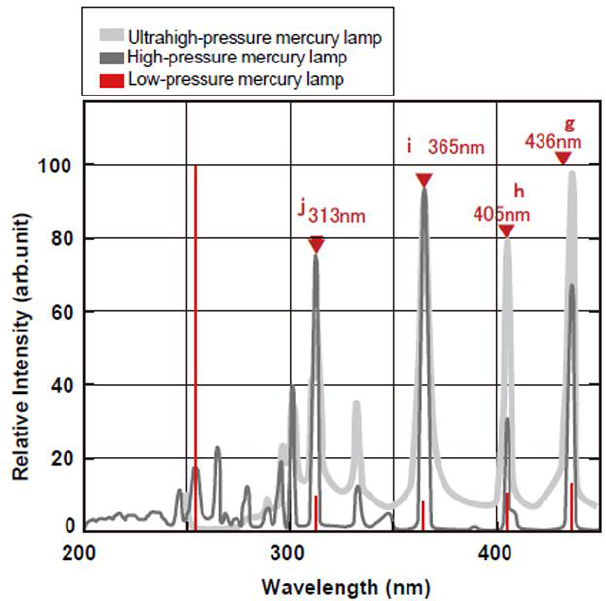
Figure 20. Spectra of low pressure (red), high-pressure (dark gray), and ultrahigh-pressure mercury lamps (light gray). The wavelength range of DUV-LEDs with high efficiency (270–300 nm) does not overlap the strong spectral lines of mercury lamps, showing the advantage of the DUV-LEDs to UV bulbs. [Permitted to be reproduced from Hikari Alliance [150].]. Another advantage of DUV-LEDs over UV bulbs is their weak infrared irradiation. The application of UV curing is often limited by the strong heat flux due to infrared irradiation mixed